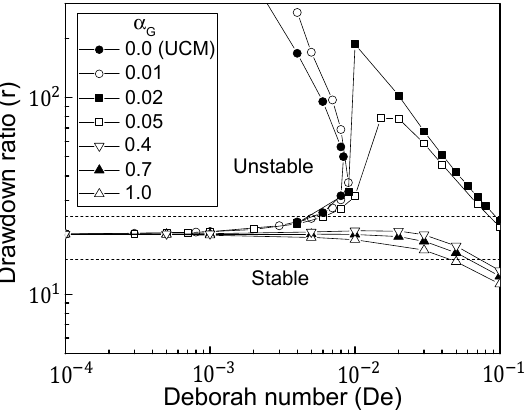
α values. Here, α represents a G G α = it is identical to the upper-convected Maxwell G